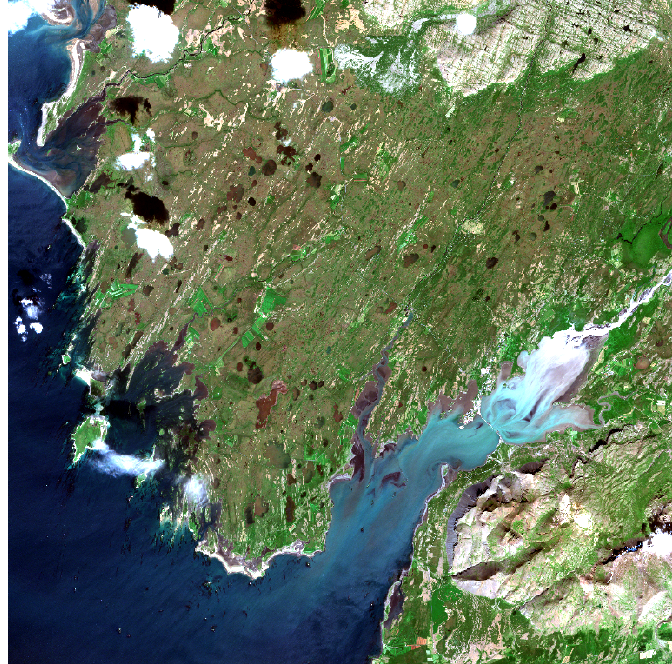
Figure 13. RGB image of the dataset used for the quantitative evaluation of all methods for 360 m to 60 m